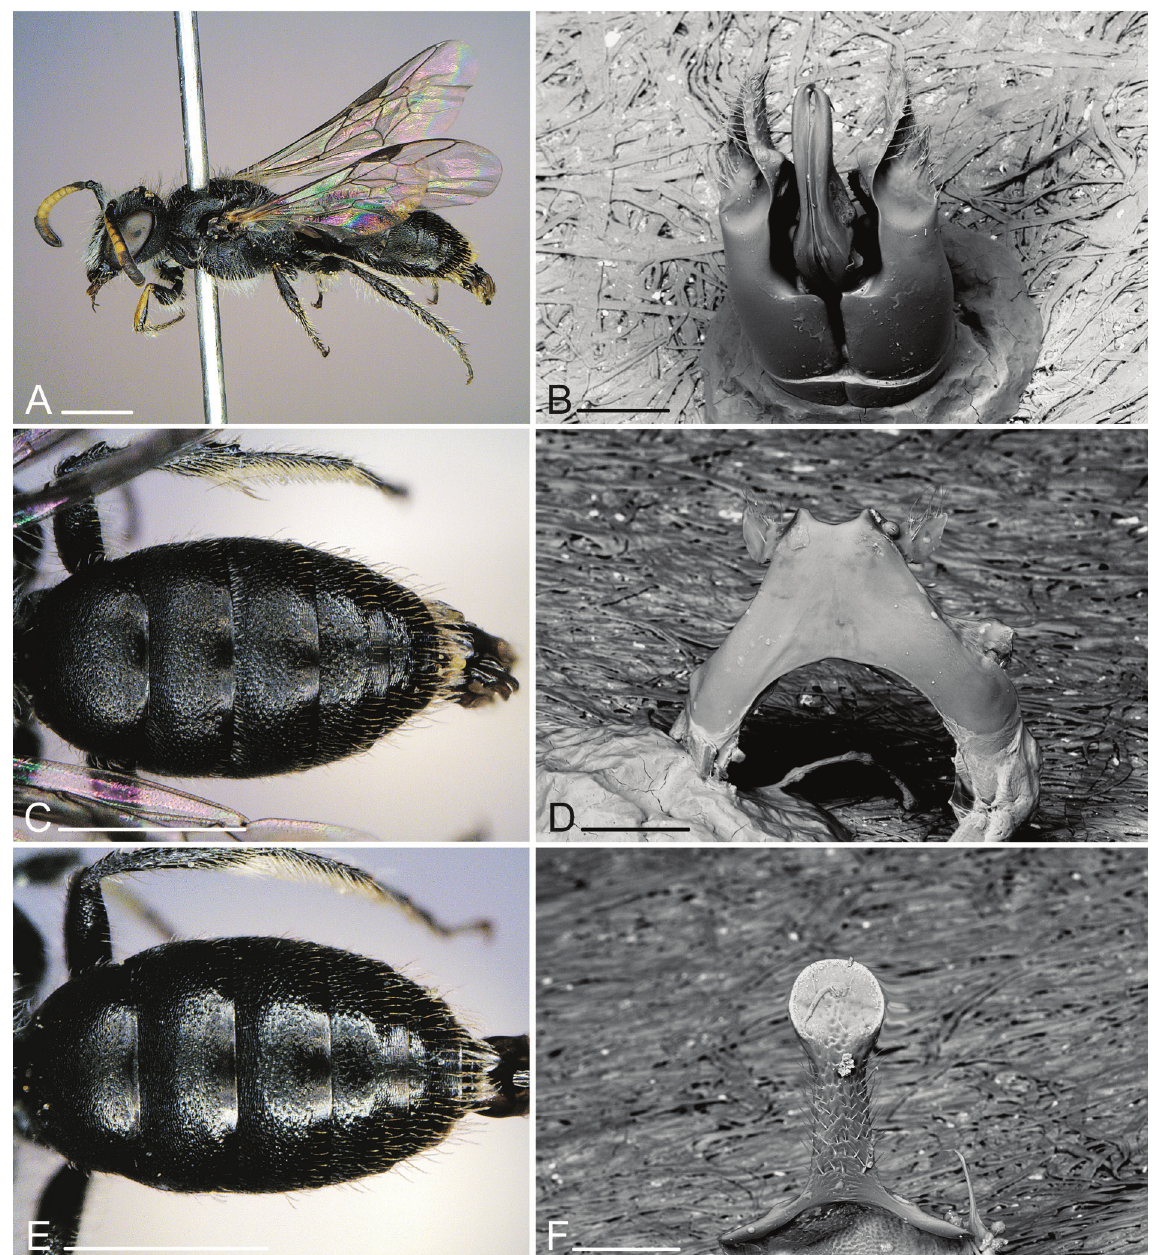
Fig. 17. Scrapter nanus sp. nov., ♂. A . Lateral view. B . Genitalia (dorsal view, SEM). C . Metasoma (dorsal view). D . S7 (dorsal view, SEM). E . Metasoma (dorsal view). F . S8, apical end (SEM). Scale bars: photos: 1 mm, SEM: 0.1